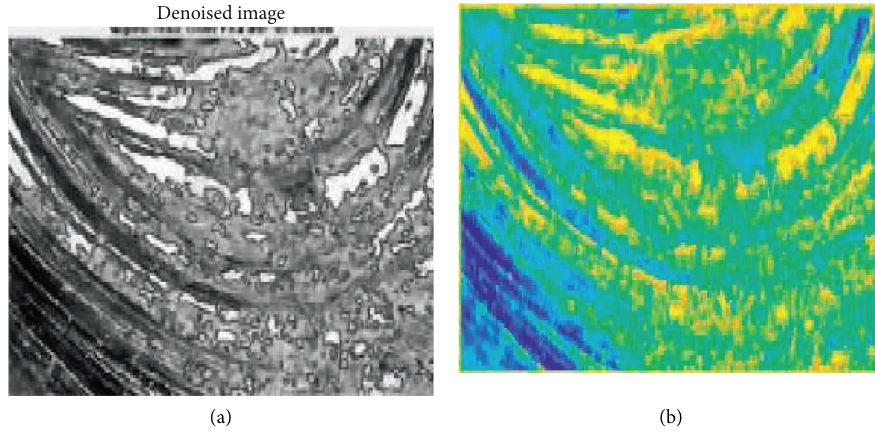
Figure 7: (a) Denoised crack image. (b) Pixel classifed crack image.